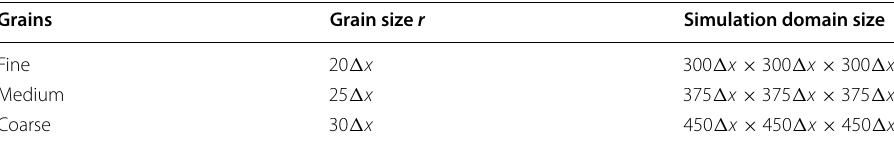
Table 2 Simulation domains corresponding to the initial grain size r for multigrain simula- tions